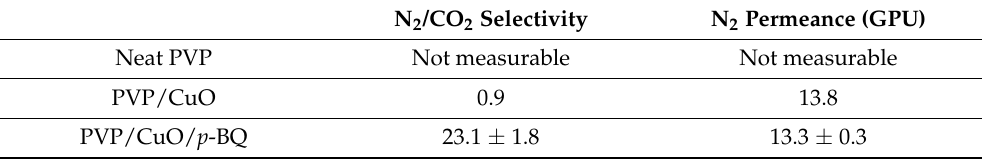
Table 1. Separation performance of neat PVP, PVP/CuO, and PVP/CuO/ p -BQ composite membranes.